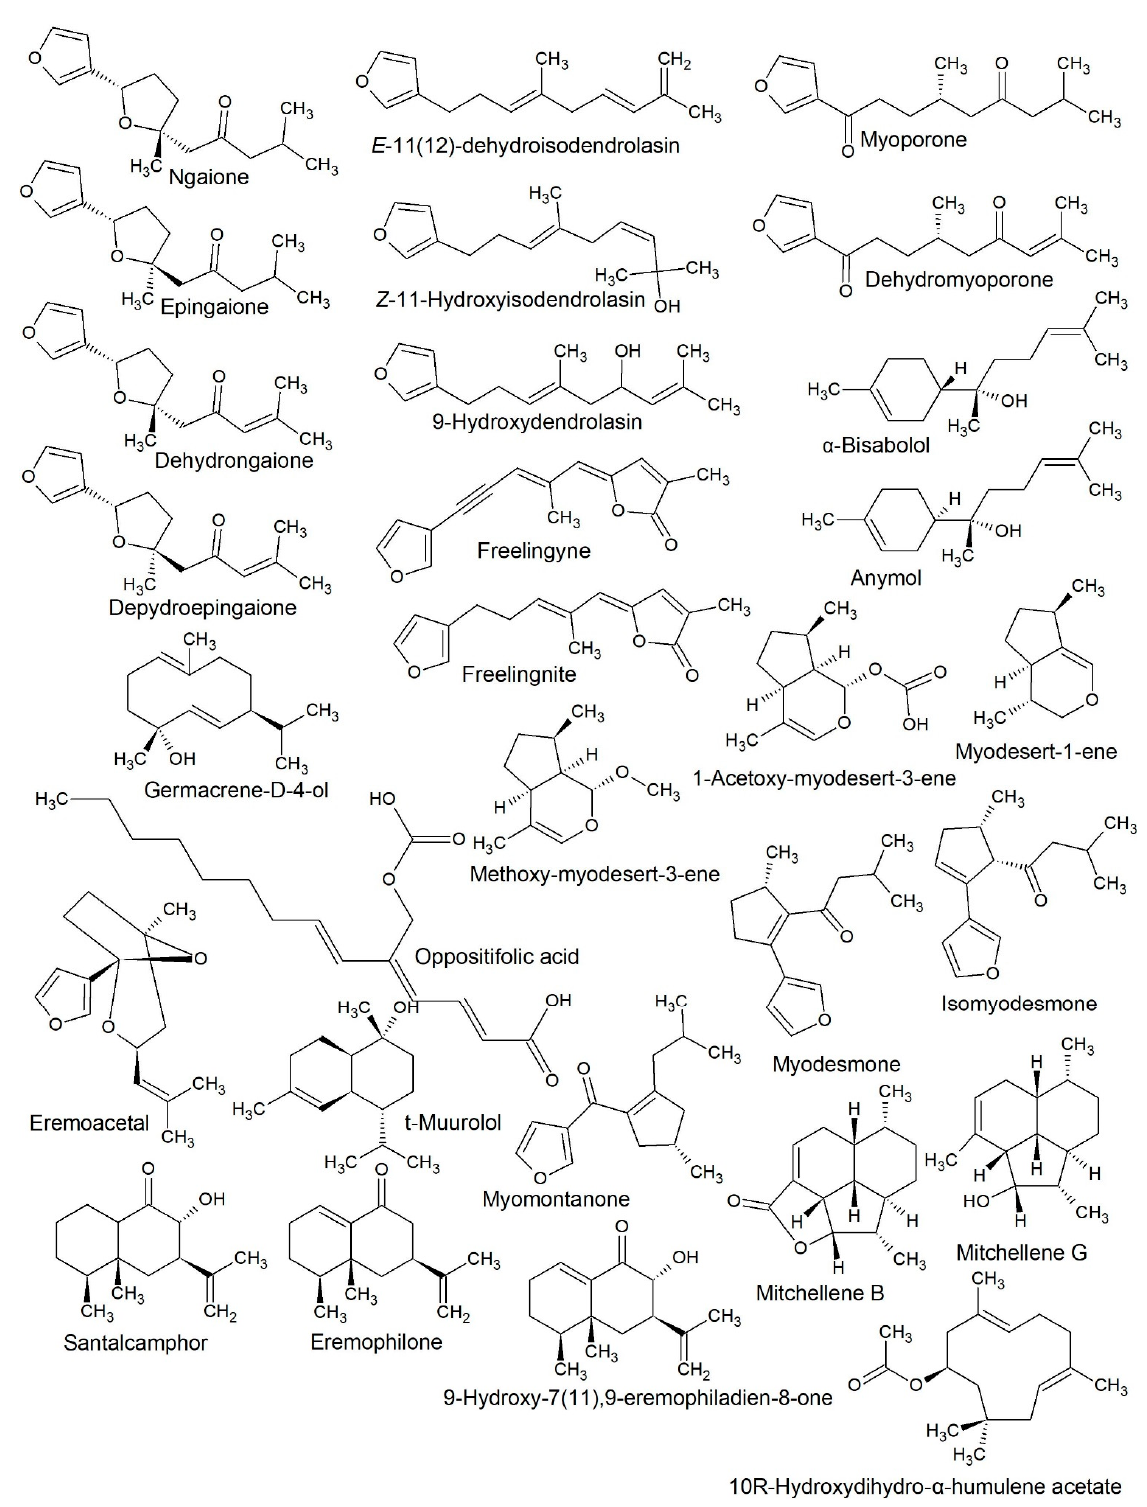
Figure 9. Uncommon or new sesquiterpenes isolated from species of Eremophila and assigned in the current study.